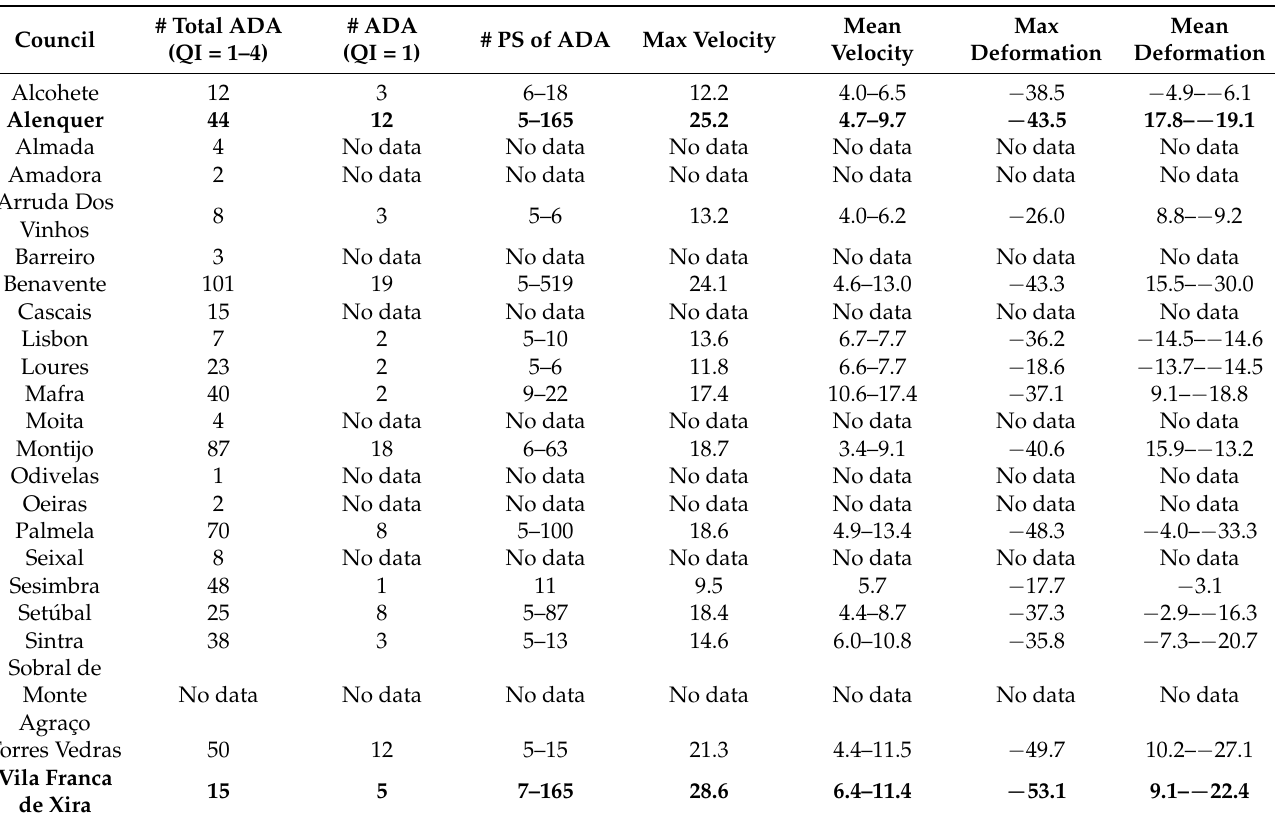
Table 5. Main parameters of ADA with QI = 1 for each council in descending trajectory. Number of PS, velocity (mm year − 1 ), and deformation (mm) are shown according to the ADA with QI = 1. In bold are the councils corresponding to the local study